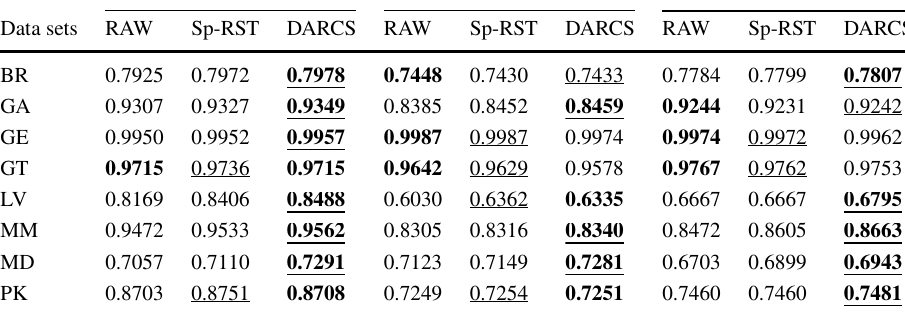
per partition classification accuracy